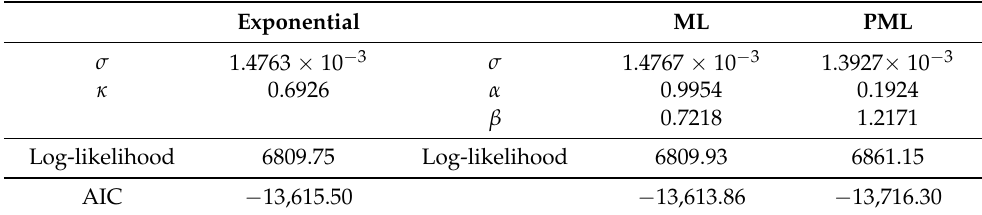
Table 1. Parameter estimates by log-likelihood maximization of one dimensional models with exponential, ML and PML kernels. Exponential ML